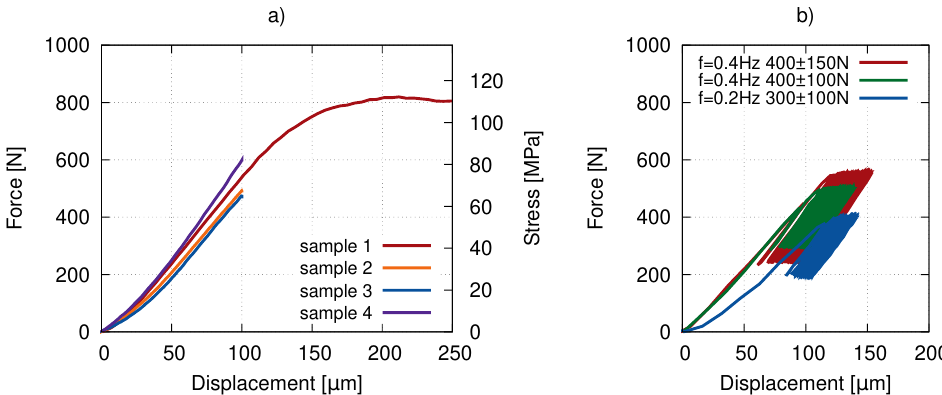
Figure 2. The loading curves of the preliminary compression tests: ( a ) quasi-static loading in an elastic and post-yield regime and ( b ) the low-cycle fatigue